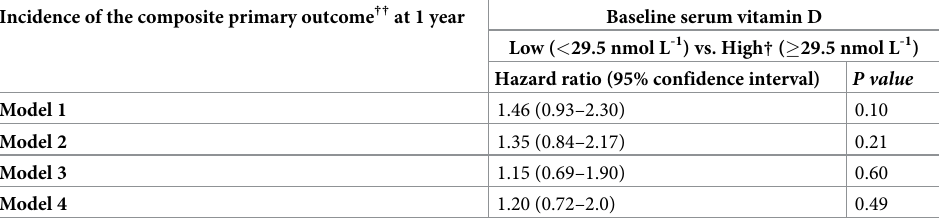
Table 2. Univariate and multivariate Cox regression for the association between serum vitamin D and the inci- dence of the composite primary outcome at 1 year. Incidence of the composite primary outcome †† at 1